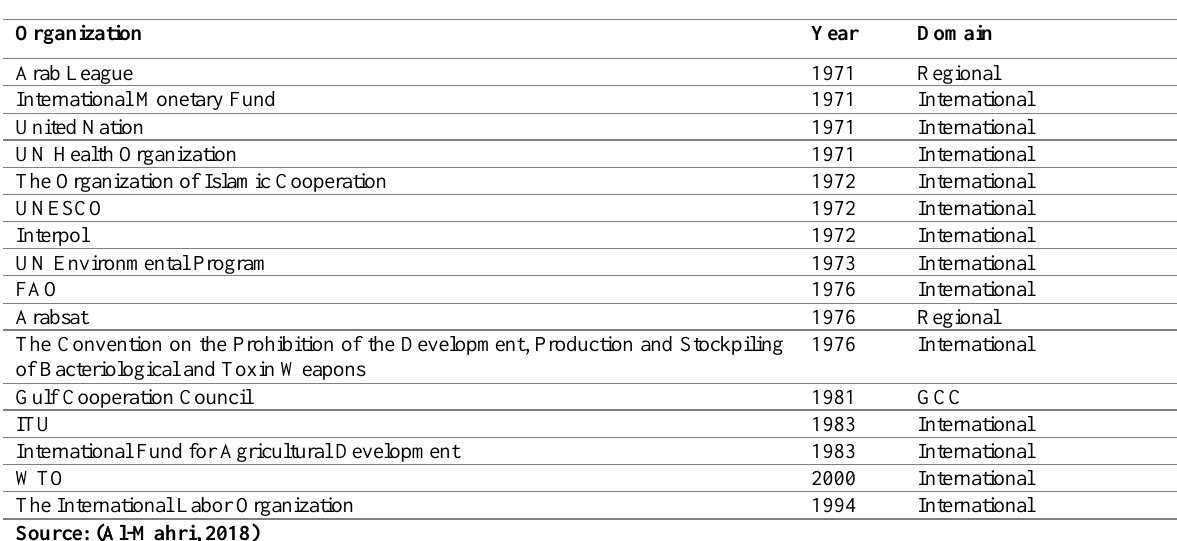
Table 7: List of international & regional